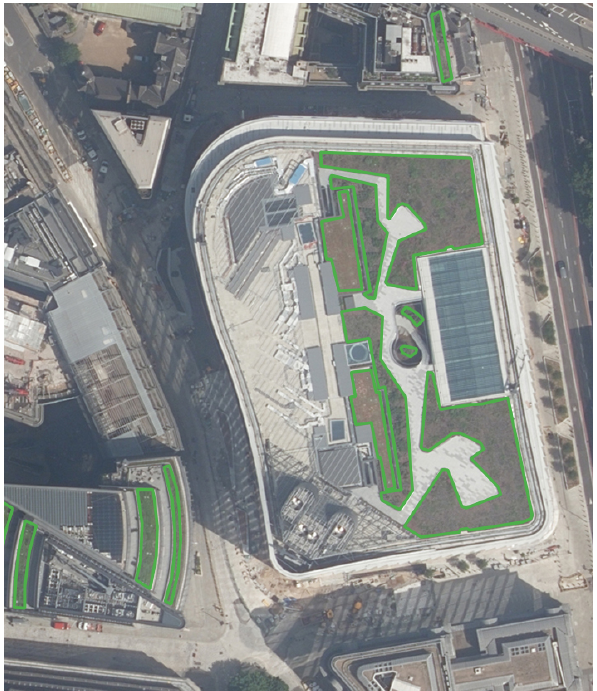
Figure 5. Example of training polygons. The area outlined in green was manually identified as being a green roof in this aerial imagery. Imagery © Getmapping Plc. Image location is shown in Fig.